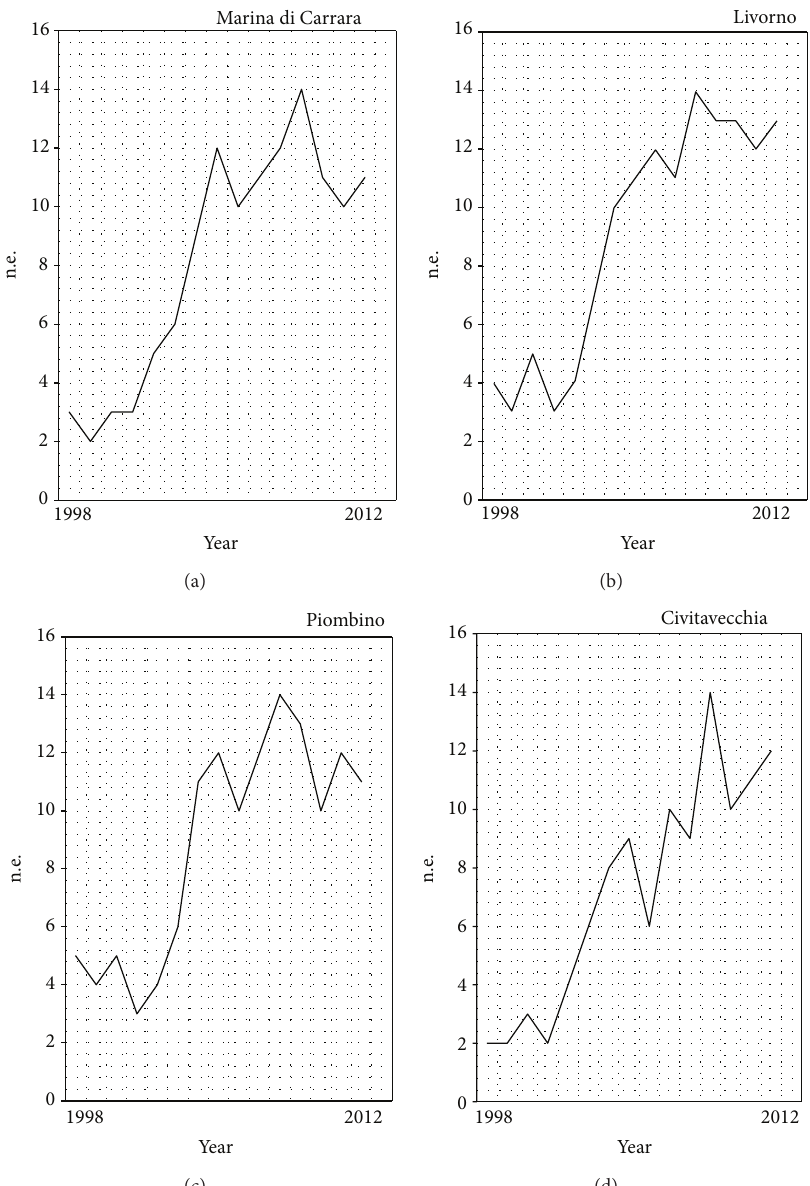
Figure 4: Occurrences from 1998 to 2012 of Newtonian meteotides events in Marina di Carrara, Livorno, Piombino, and Civitavecchia (n.e. number of